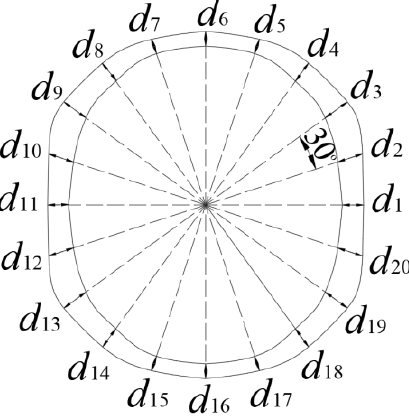
Figure 4. Formulae for the average, range, and variance of the rebar cladding thickness.